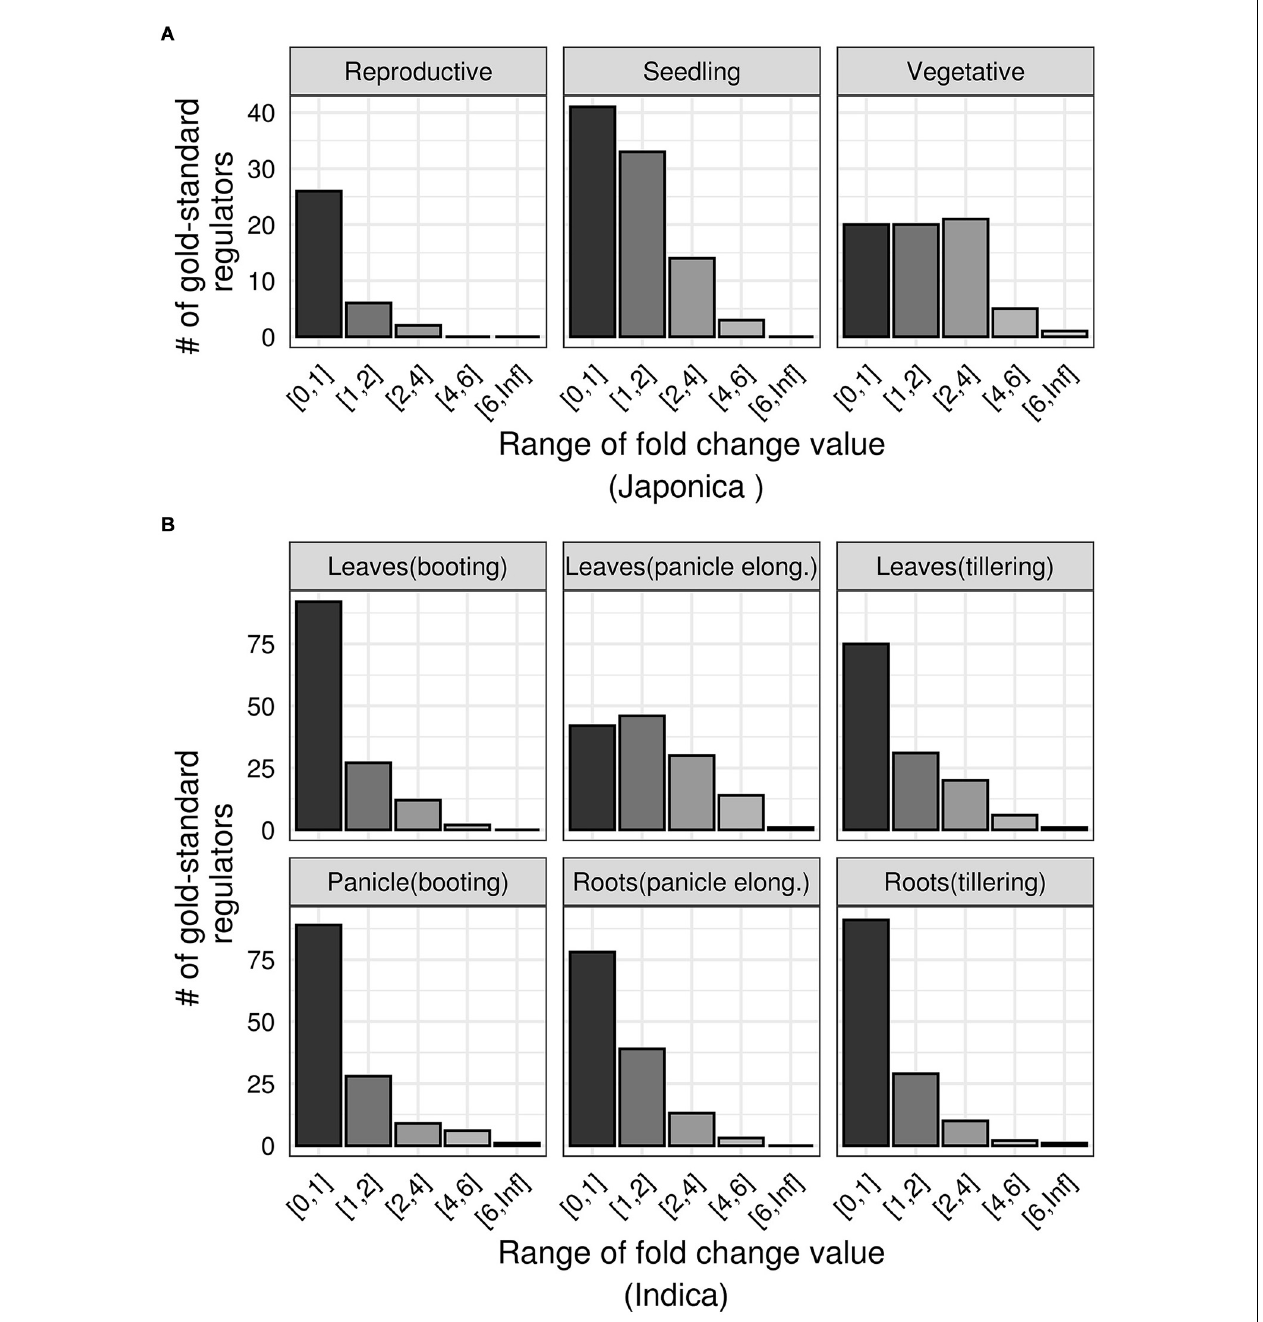
FIGURE 4 | Differential expression patterns of gold standard drought regulators. (A) The range of absolute fold-change values ( x-axis ) of gold standard TFs ( y-axis ) in three growth stages of Japonica rice variety exposed to drought (data from GSE81253). (B) The range of absolute fold-change values ( x-axis ) of gold standard TFs ( y-axis ) in multiple tissues of indica rice variety exposed to drought (data from